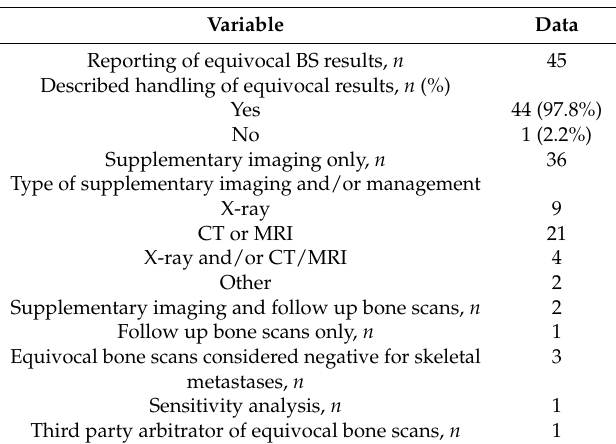
Table 2. Handling of equivocal bone scan